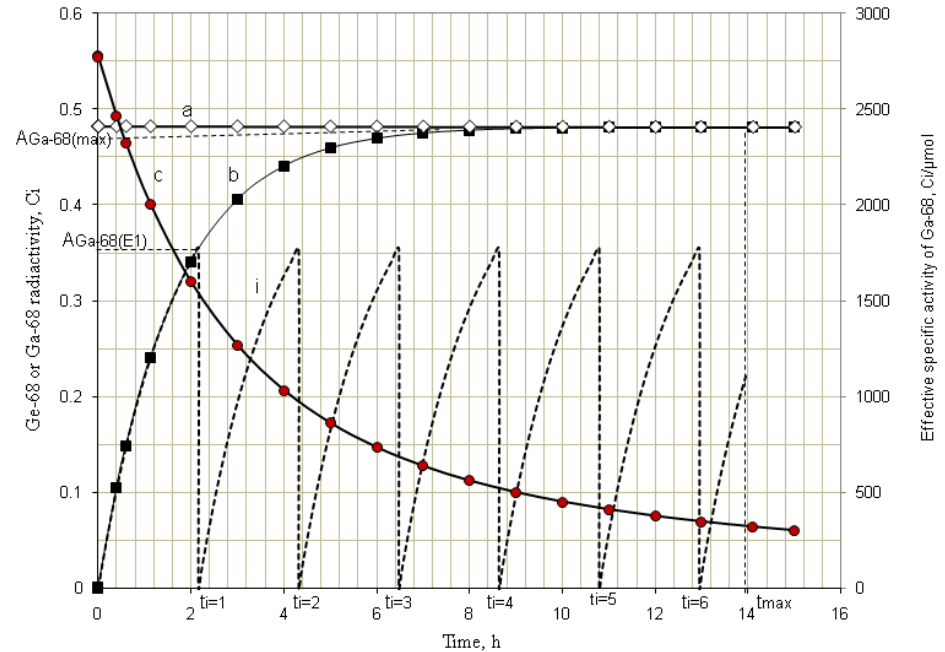
Figure 6. Kinetics of radioactive decay/ 68 Ga-activity build-up in the generator eluted with an early elution regime: a, 68 Ge-activity; b, 68 Ga-activity build-up from beginning; i, 68 Ga-activity growth/eluted at 2.1-h elutions; c, Effective Specific Activity of 68 Ga in the system of 68 Ga-radioactivity build-up from beginning (the detailed discussion is available in Section